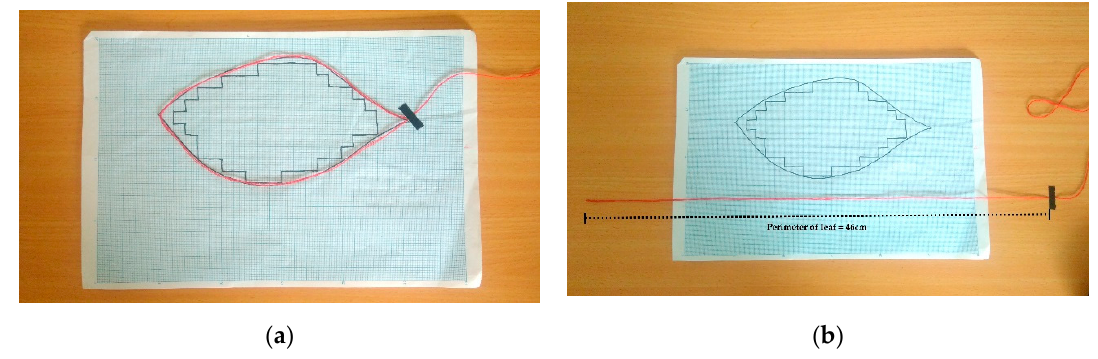
Figure 9. The length of leaf in millimeter paper. ( a ) String follows the edge of leave picture on a millimeter grade paper; ( b ) The length of the string as the leave perimeter.